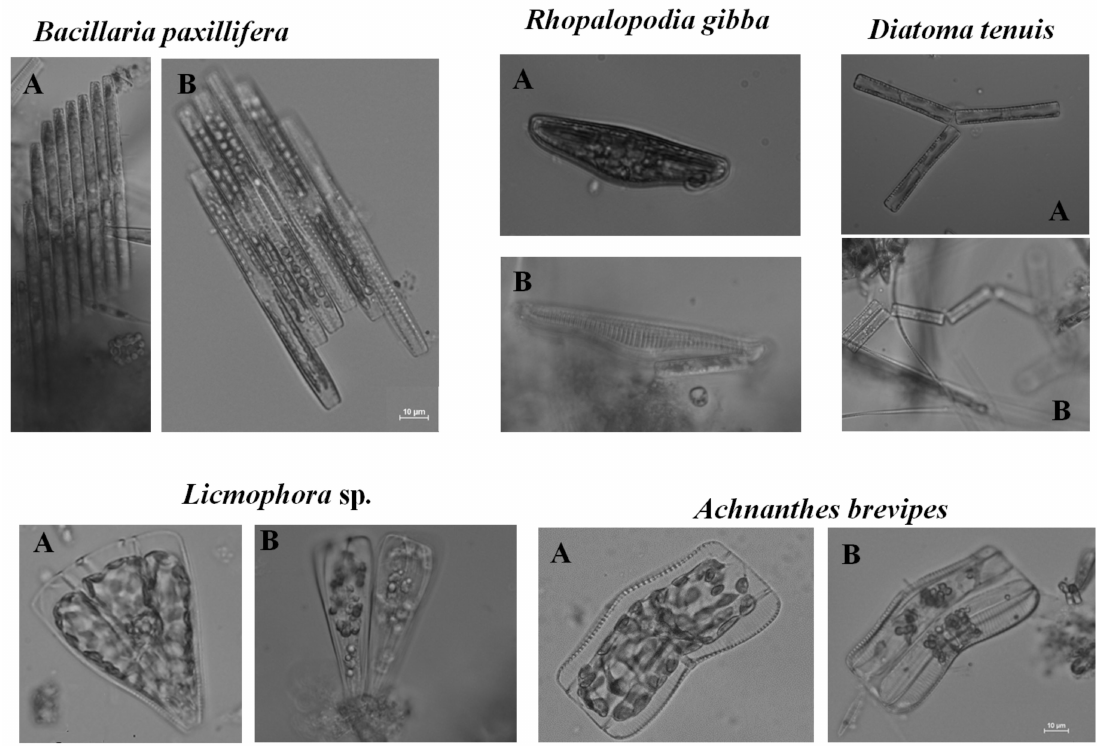
Figure 2. Cells of selected taxa with normal chloroplasts (A) and with abnormal chloroplasts